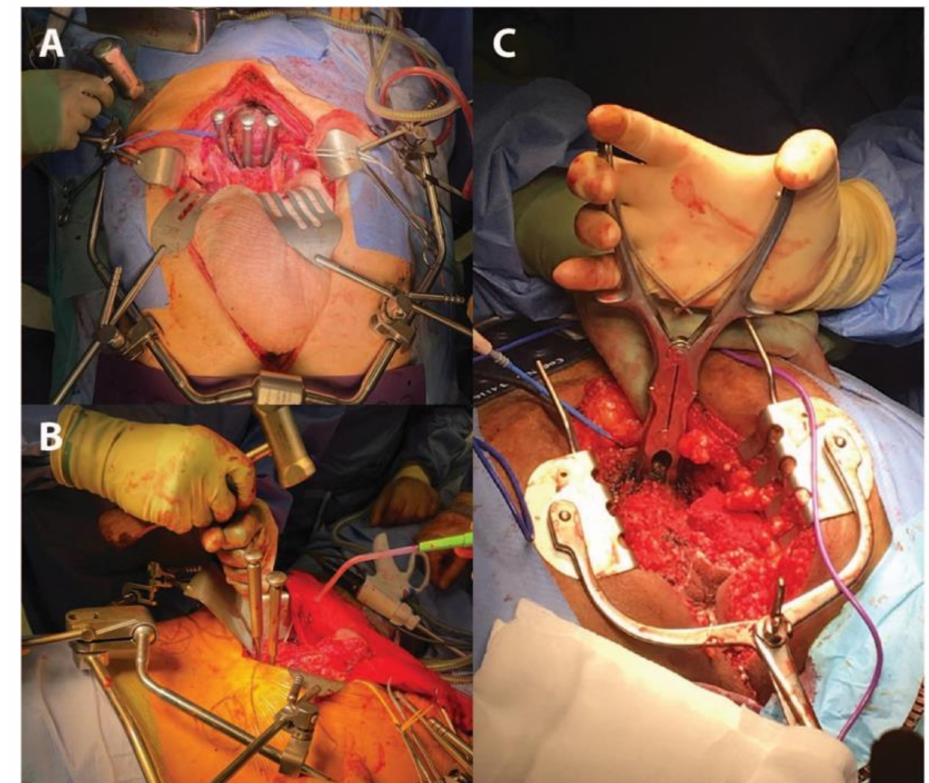
Figure 2. Sacral transection shown with osteotome or bone nibbler method. ( A ) and ( B ) In the supine position, osteotomes are hammered onto the desired transection level, first in the midline to breach the full thickness of the sacrum, before placing further osteotomes in series bilaterally, moving medial-to-lateral until transection has been completed. ( C ) From the prone position, the sacrum may alternatively be transected using bone